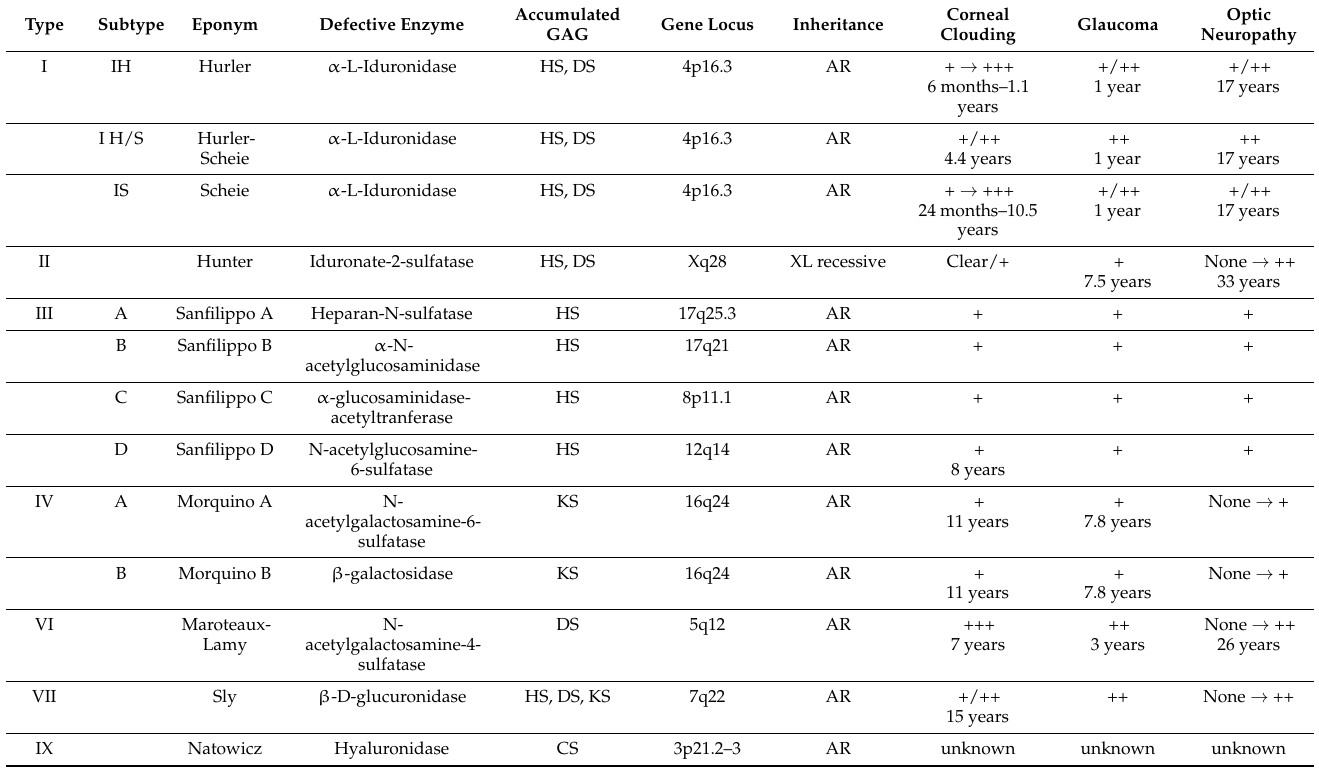
Table 2. Clinical and molecular features mucopolysaccharidosis